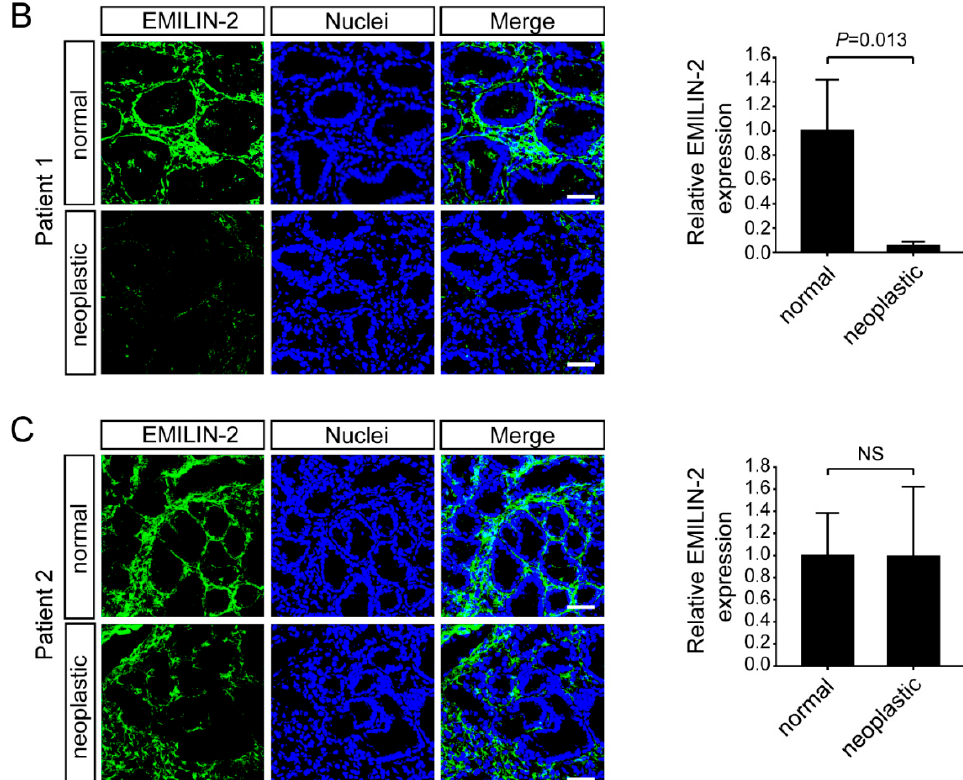
Figure 3. EMILIN-2 expression is decreased in some gastric cancer patients. ( A ) Representative images of normal gastric mucosa samples stained with anti-EMILIN-2 (green). Nuclei were stained with TO-PRO ® 3 (blue). Scale bar = 50 µ m. ( B ) Images and quantification of the expression of EMILIN-2 (green) in normal and in gastric cancer samples from Patient 1. Nuclei were stained with TO-PRO ® 3 (blue). Scale bar = 50 µ m. ( C ) Representative images and quantification of the expression of EMILIN-2 (green) in normal and in gastric cancer samples from Patient 2. Nuclei were stained with TO-PRO ® 3 (blue). Scale bar = 50 µ m. Graphs represent the mean ± SD; p values were obtained using the paired Student’s t -test. NS: not significant.